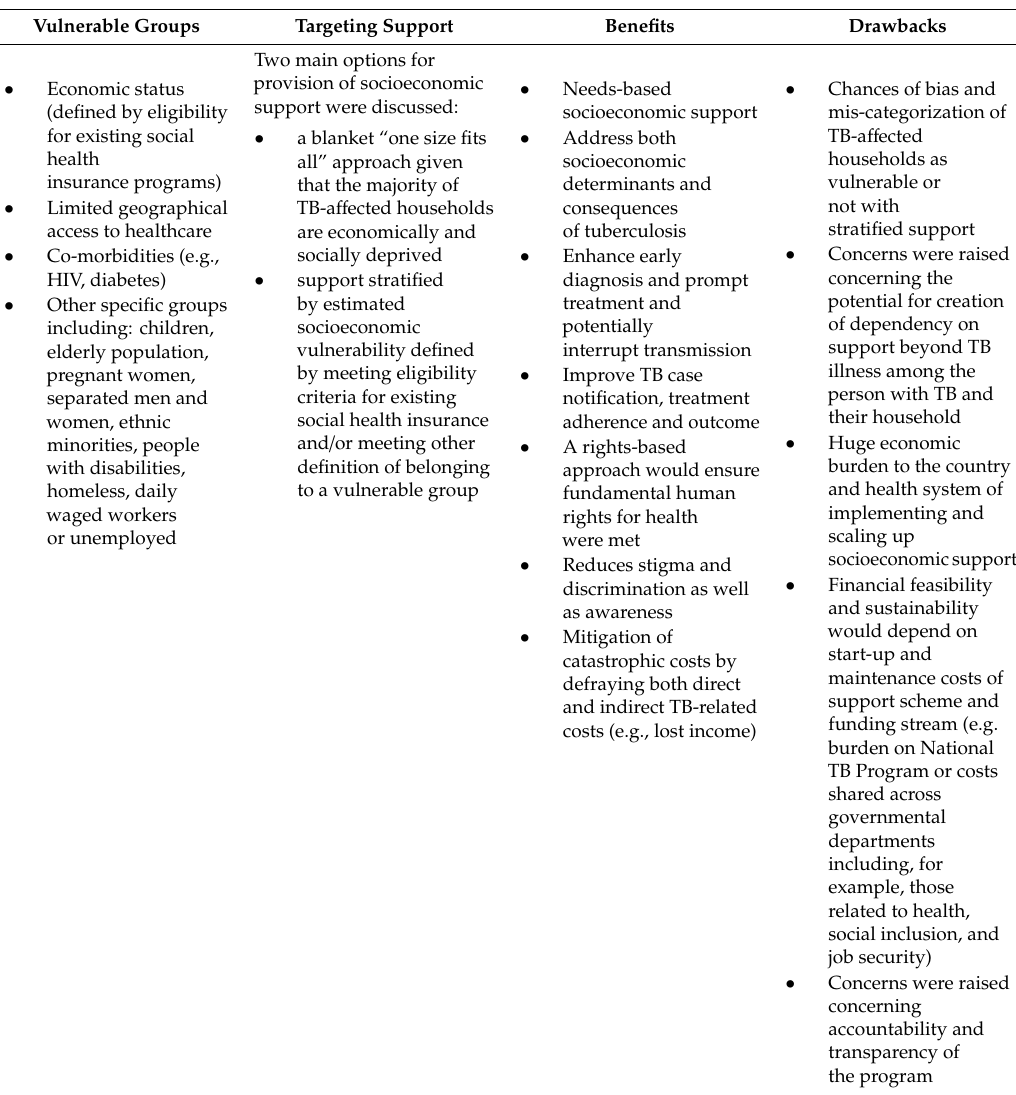
Table 2. Definitions of vulnerable groups and benefits and drawbacks of targeted